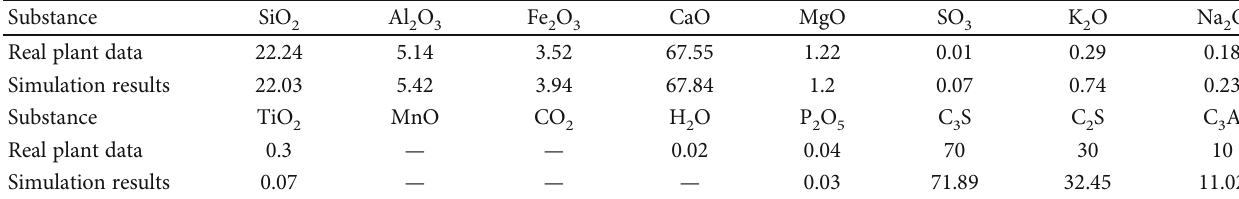
Al O 2 2 3 MnO 2